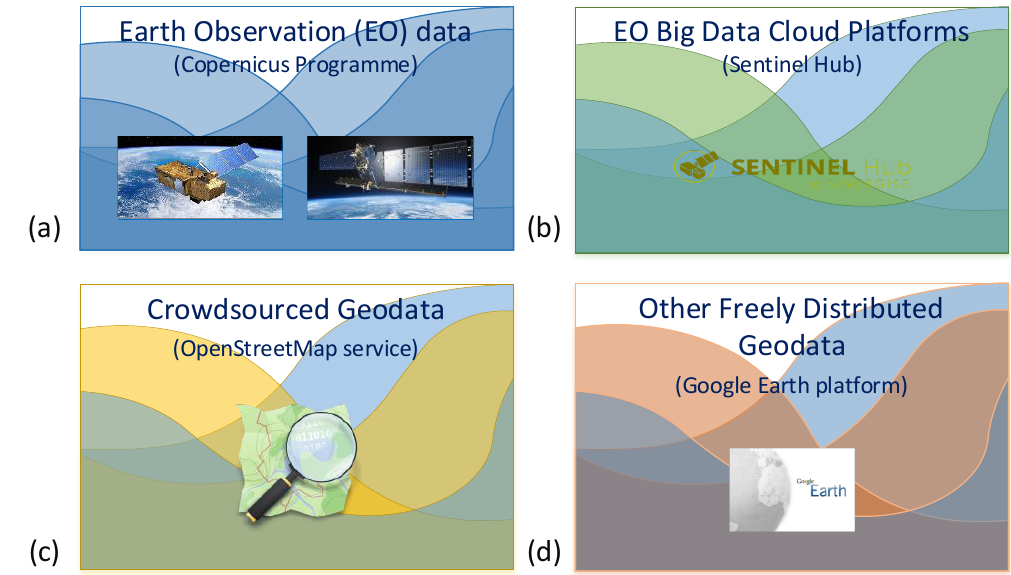
Figure 2. A schematic representation of the four “layers” of information used in this study: the Earth Observation Sentinel-1 and Sentinel-2 images ( a ), the Sentinel Hub, an Earth Observation big data cloud platform ( b ), crowdsourced geodata from OpenStreetMap ( c ) and the Google Earth platform ( d ). Through the Sentinel Hub service, radar and optical Sentinel images were retrieved (see more details below). Beyond the calibrated bands from both sensors, additional products were